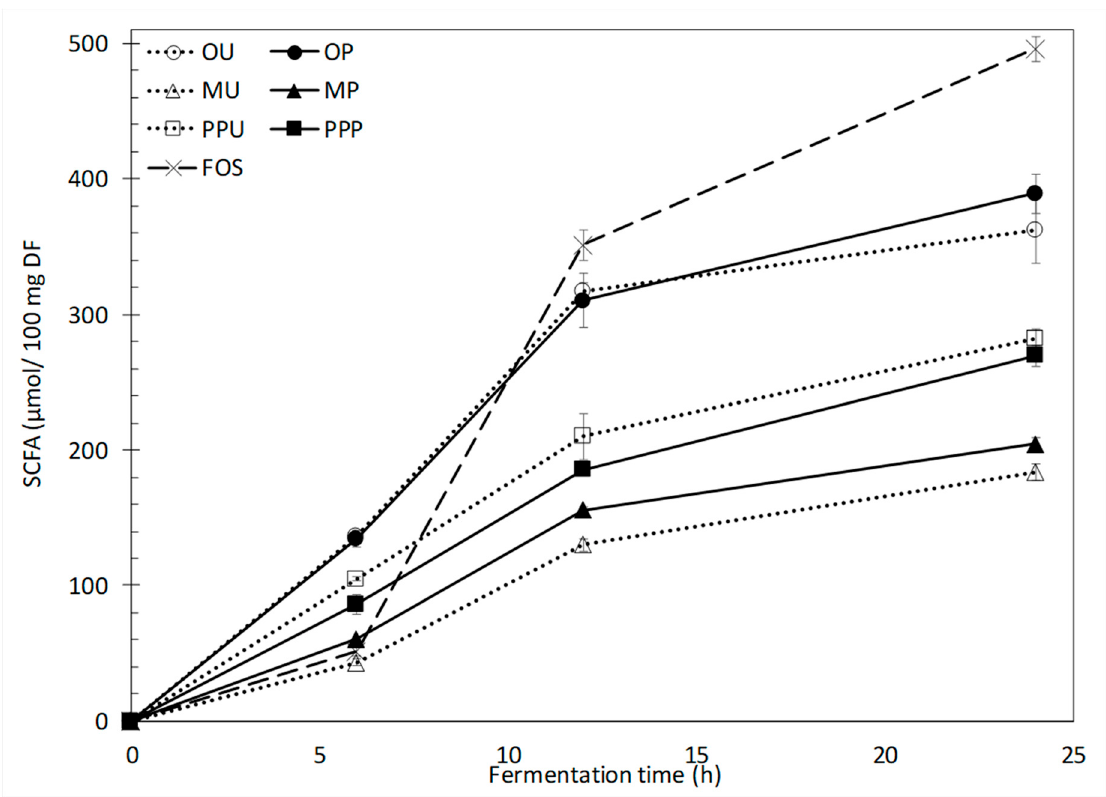
Figure 4. Short chain fatty acids (SCFA) produced during in vitro fermentations of untreated and HHP-treated fruit peels. Error bars show SD; some error bars are too small to see; n = 3. OU—orange untreated, OP—orange HHP-treated, MU—mango untreated, MP—mango HHP-treated, PPU—prickly pear untreated, PPP—prickly pear HHP-treated, FOS—fructo-oligosaccharides.